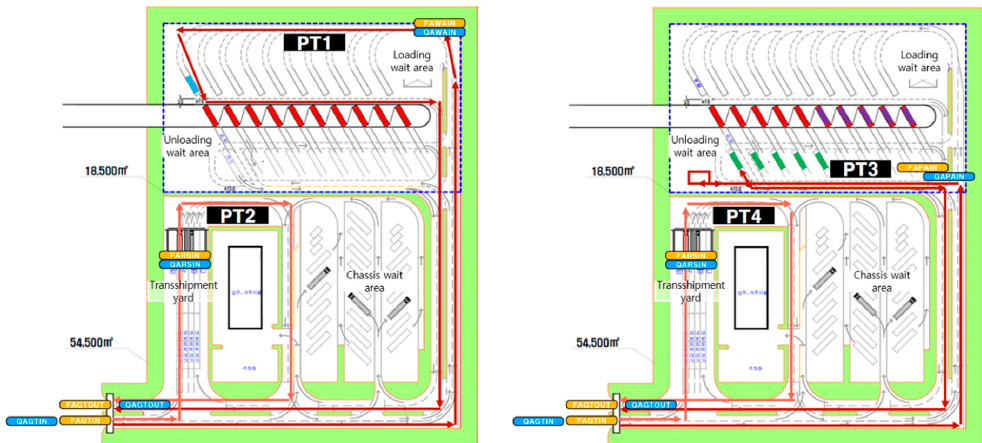
Figure 8. Operation logic for yard tractor (left: unloading; right: loading).